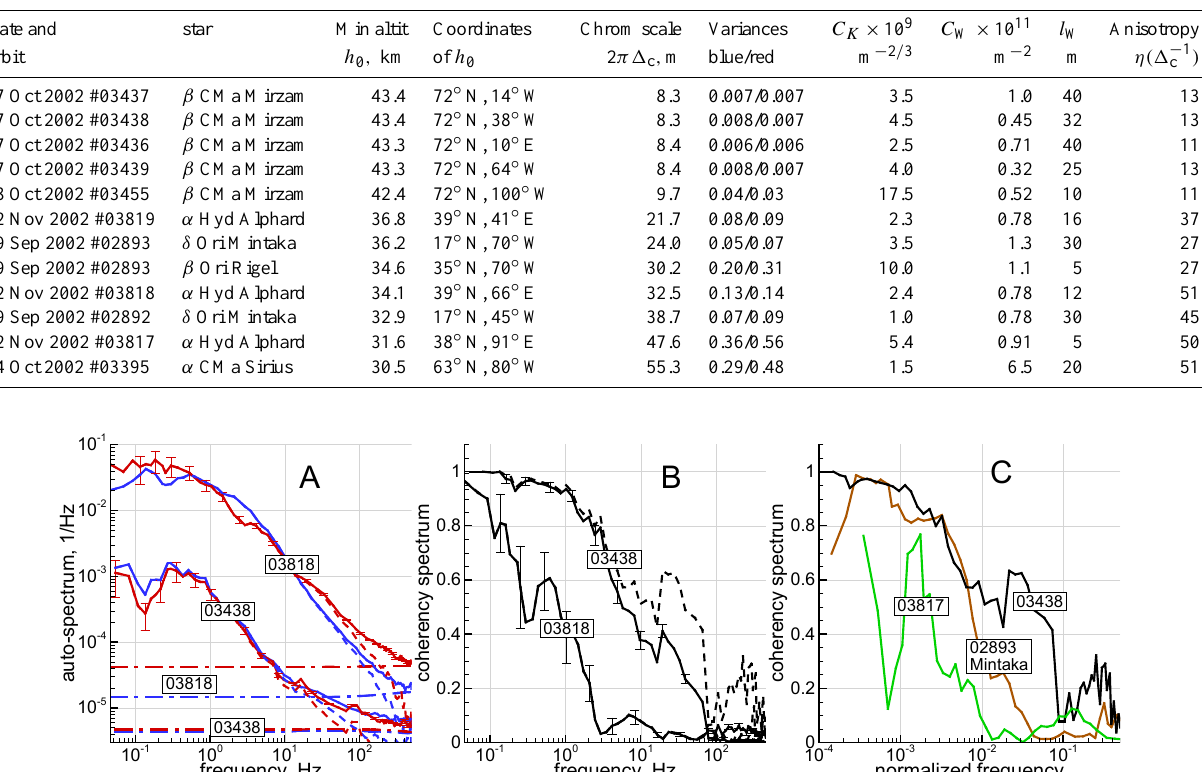
π 2 f ∆ , for different values of the chromatic shift. The 683 c v h